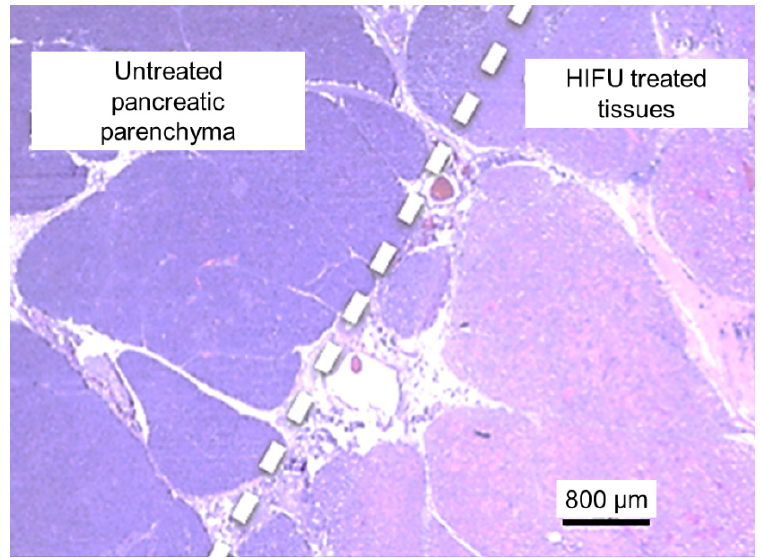
Figure 5. Histological examination of the treated pancreatic parenchyma using hematoxylin and eosin stain. The transition between untreated and treated tissues is typically about 100 µm.